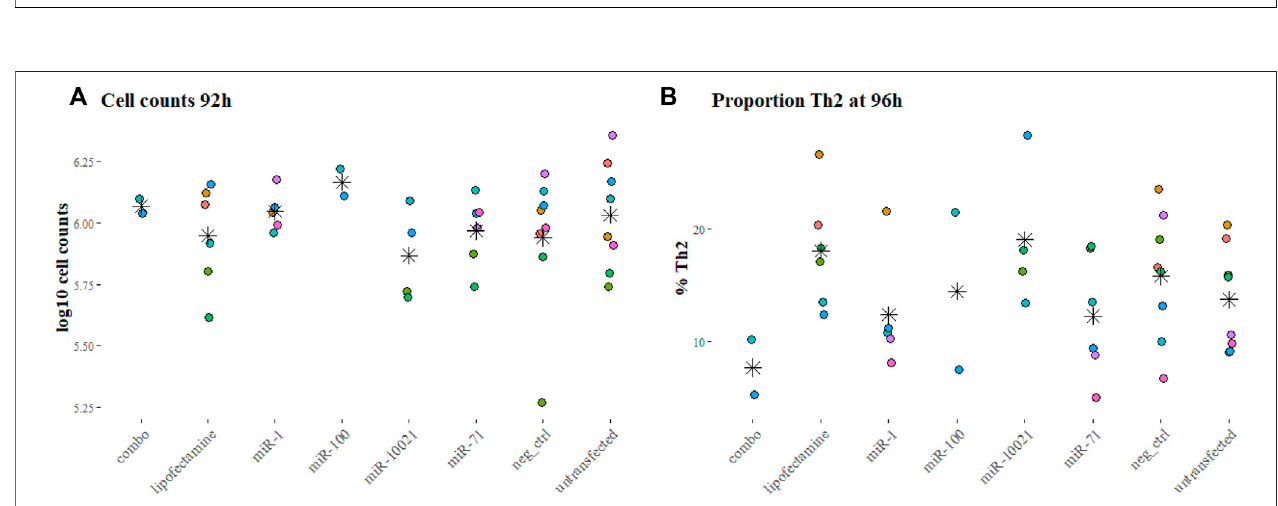
FIGURE 2 | Cell counts and proportions of fully differentiated Th2 cells. Cell counts after 92 h into culture (A) and proportion of Th2 cells at the end of the experiments (96 h, (B) , as re fl ection of IL-13 positive labeling, measured by FACS. Colors indicate independent experiments; stars indicate the mean for each miRNA treatment. Cell counts are expressed in log 10 of average cell